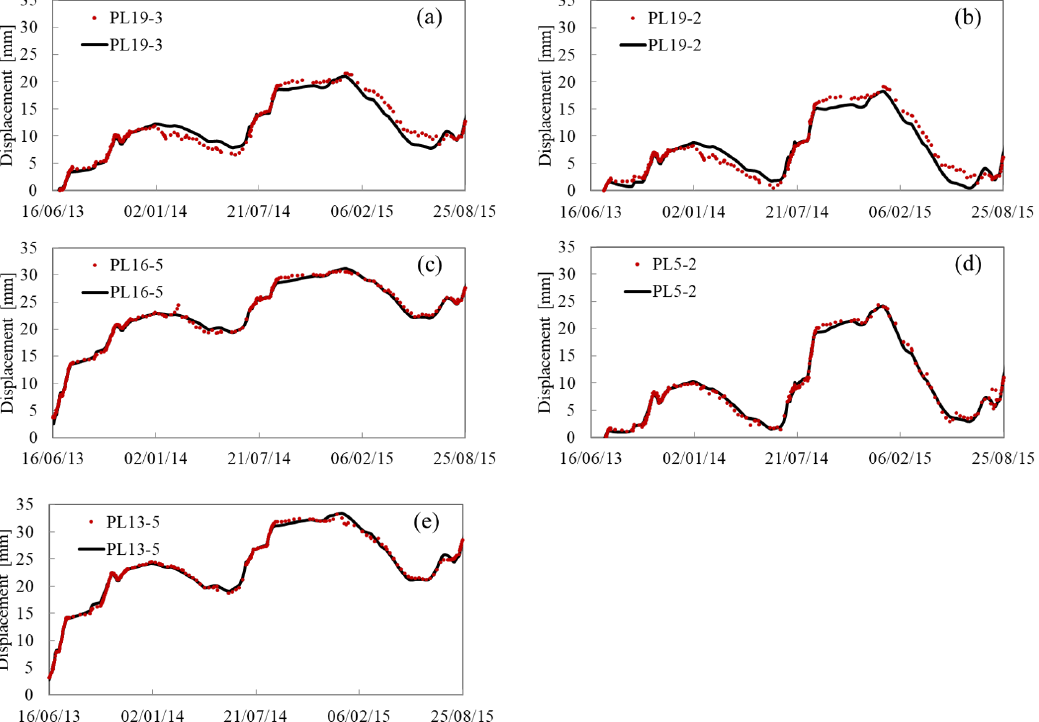
Figure A1. The fitting and forecast results of Class 2: ( a ) IP 19-3; ( b ) IP 19-2; ( c ) PL 16-5; ( d ) PL 5-2; and ( e ) PL 13-5.